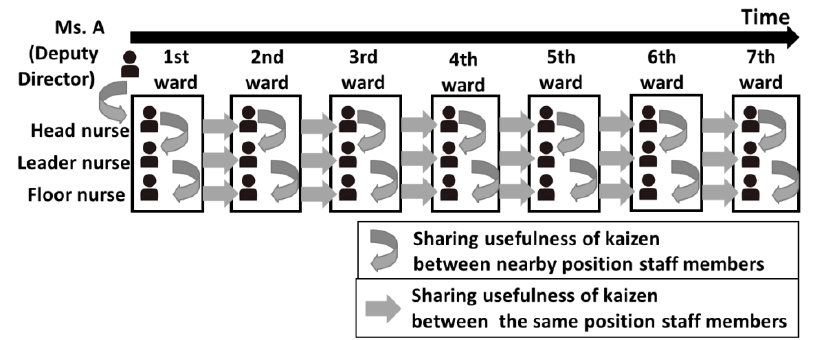
Figure 2. Introduction of kaizen in Hospital